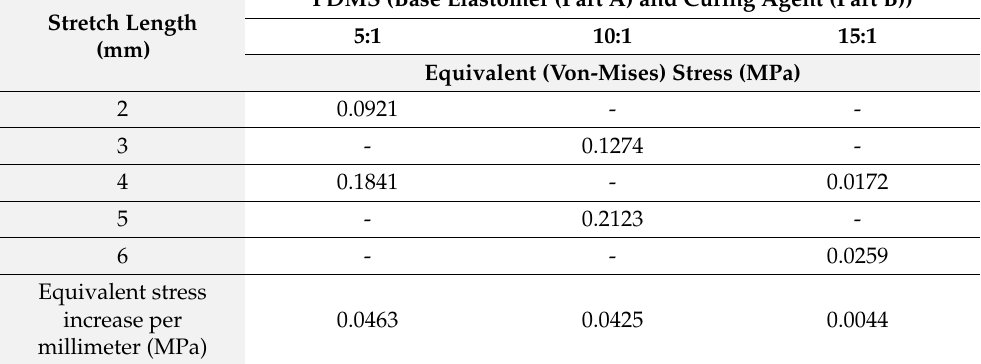
Table 2. Effects of stretching length on the mold stress within the elastic range of PDMS at different composite